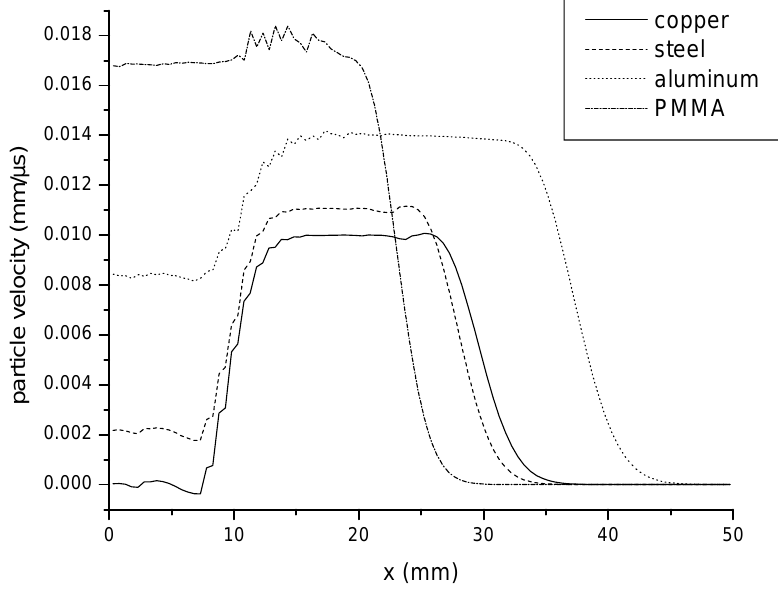
Fig. 5. Particle velocity distribution at